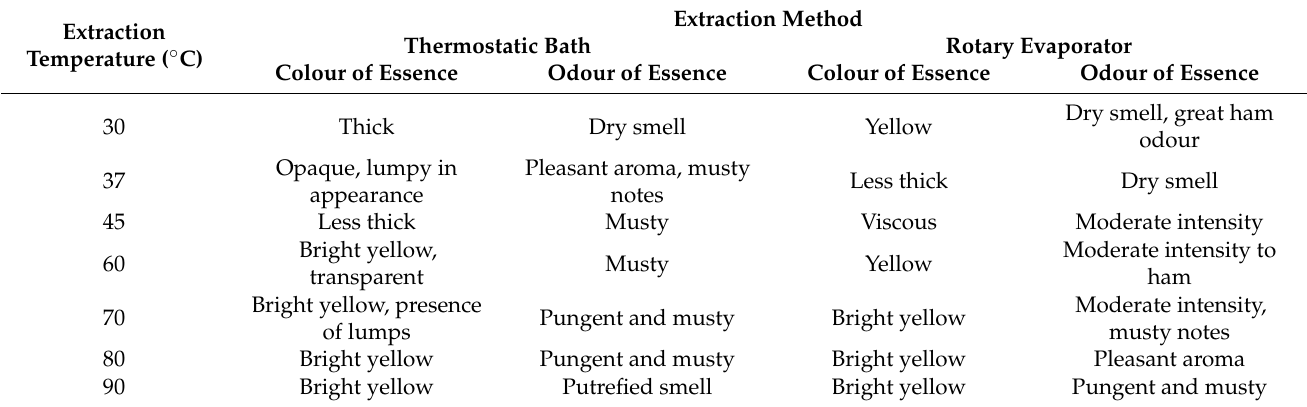
Table 1. Sensory results obtained after subjecting the ham fat to different temperatures in a thermo- static bath and rotary